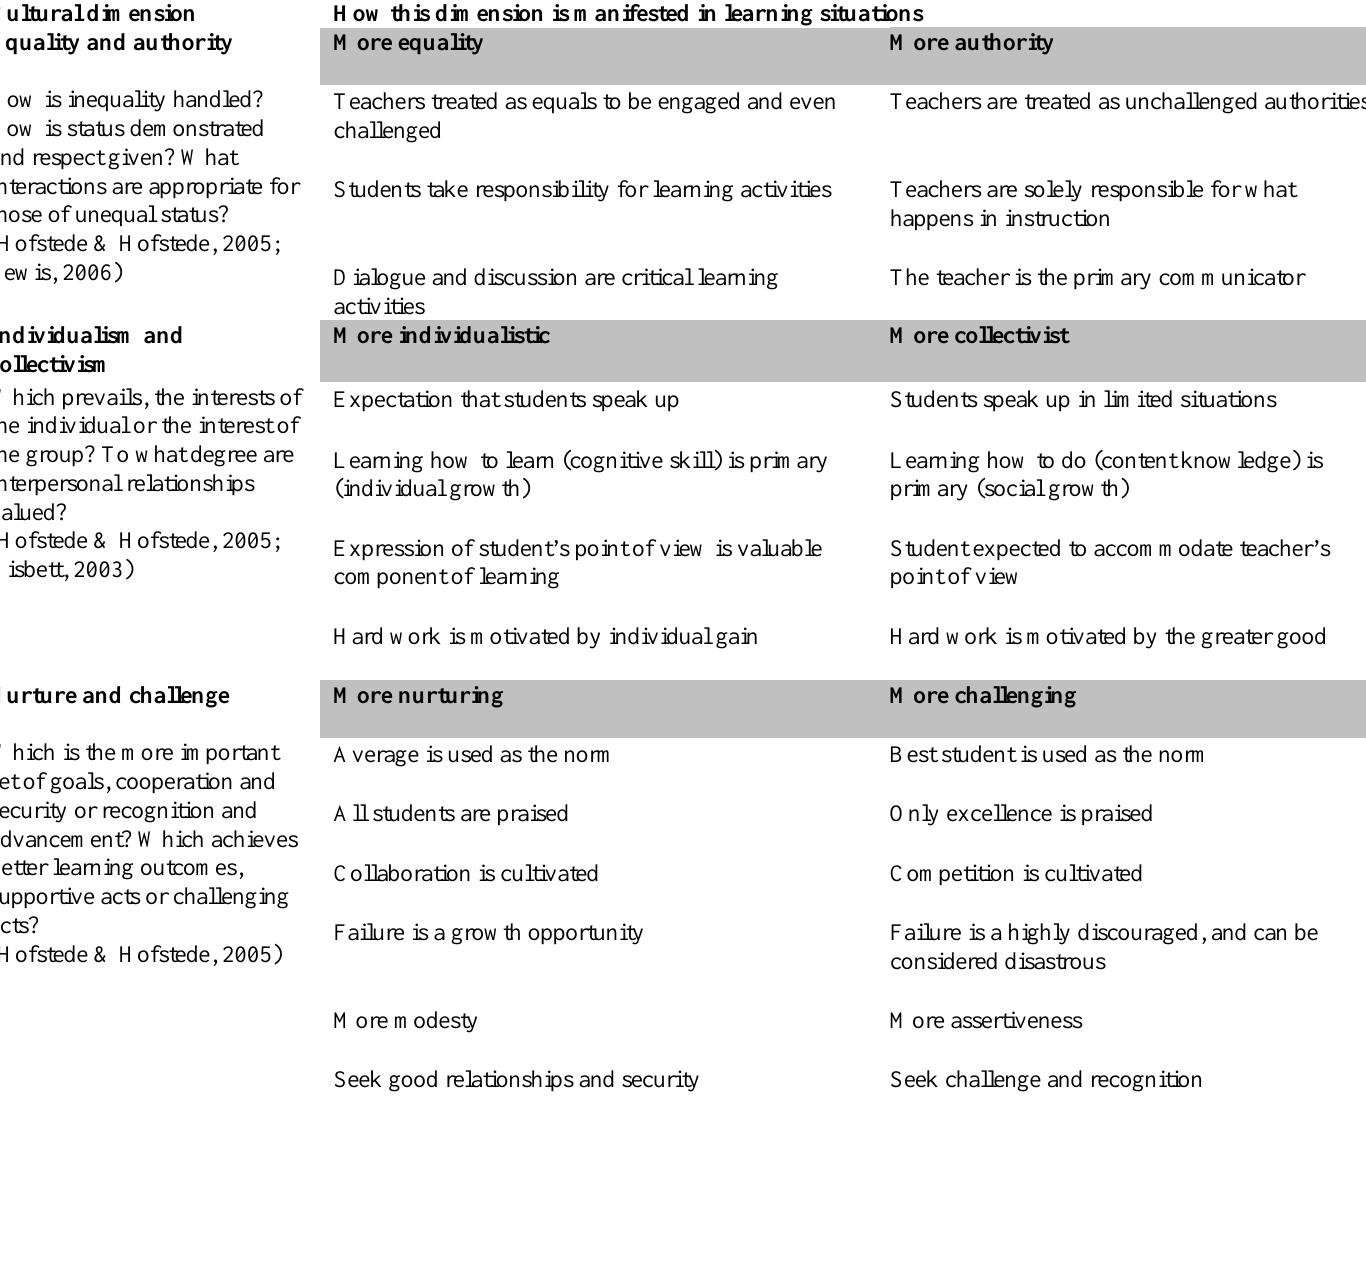
Table 1 The Cultural Dimensions of Learning Framework Social